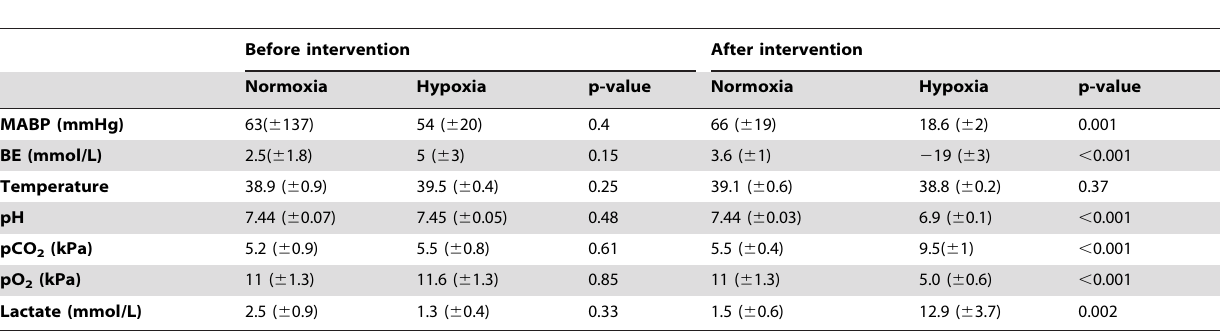
Table 2. Clinical parameters of the study cohort measured after a one hour stabilization/relaxation procedure before and after intervention.